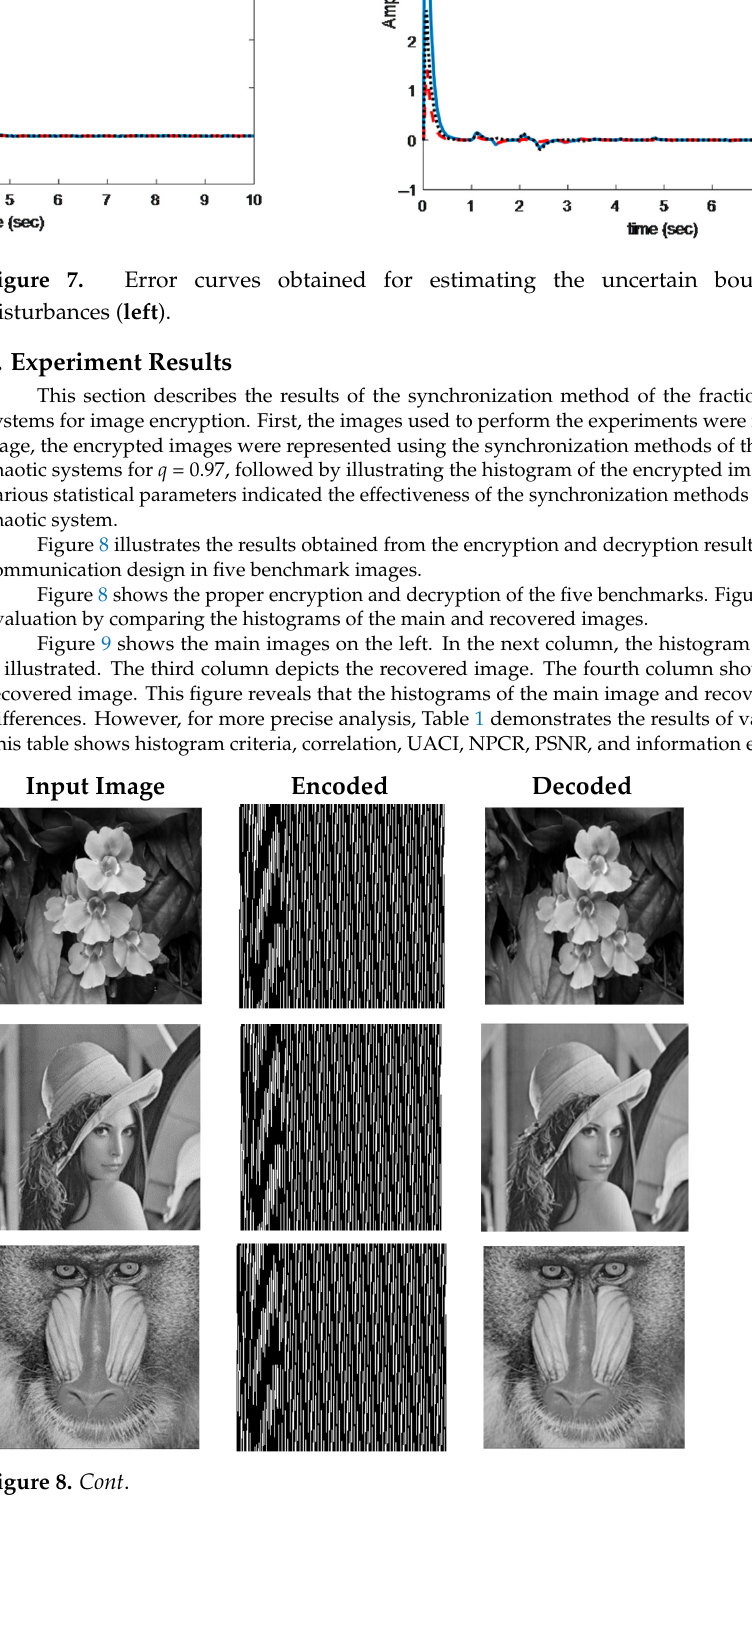
Figure 8. Displayed Benchmark images encryption using synchronization of the fractional-order Chen systems( q= 0.97). Figure 8 shows the proper encryption and decryption of the five benchmarks. Figure 8 gives a more precise evaluation by comparing the histograms of the main and recovered images. Figure 9 shows the main images on the left. In the next column, the histogram of the encrypted image is illustrated. The third column depicts the recovered image. The fourth column shows the histogram of the recovered image. This figure reveals that the histo- grams of the main image and recovered images have slight differences. However, for more precise analysis, Table 1 demonstrates the results of various statistical criteria. This table shows histogram criteria, correlation, UACI, NPCR, PSNR, and information entropy.